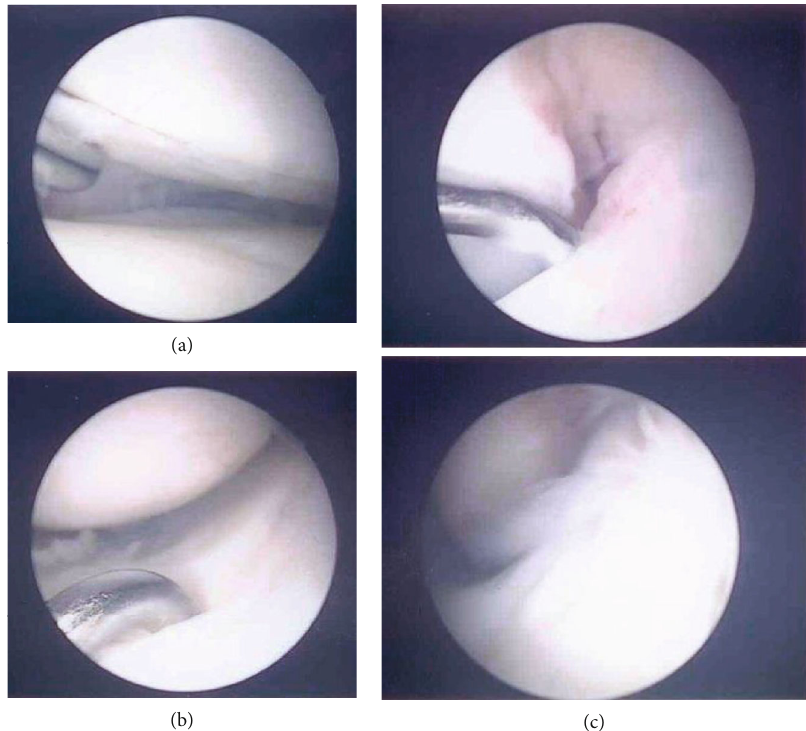
Figure 4: Arthroscopic views of the medial (a) and lateral (b) meniscus and the ACL (c) 3 months postoperatively. The ACL and both menisci were